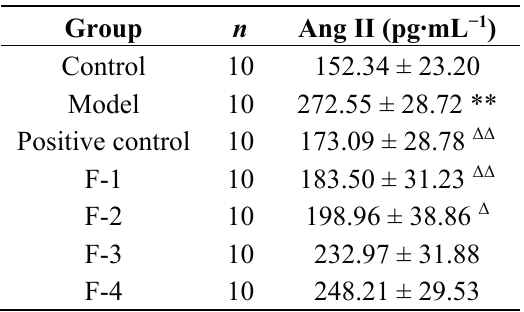
Table 2. Content of Ang II in plasma in all groups ( x ±